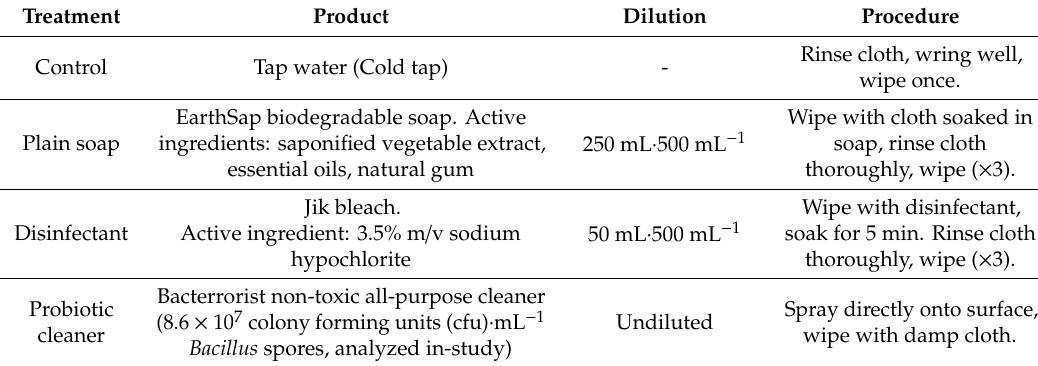
Table 1. Cleaning products and procedures based on local hospital